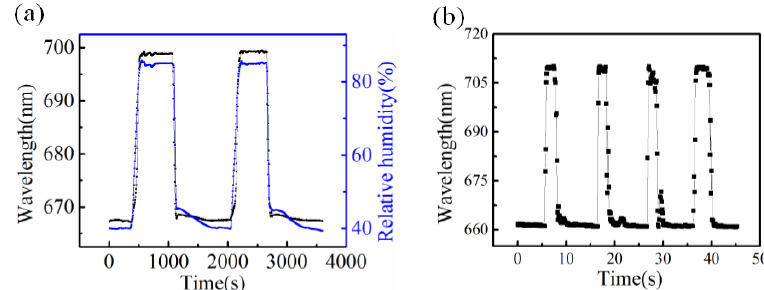
Figure 6. ( a ) Cycling response with RH changes between 40% to 85% and ( b ) human breaths response for a fiber SPR sensor with initial wavelength of 664 nm. The blue curve in ( a ) represents the data acquired from the electric hygrometer for calibration.